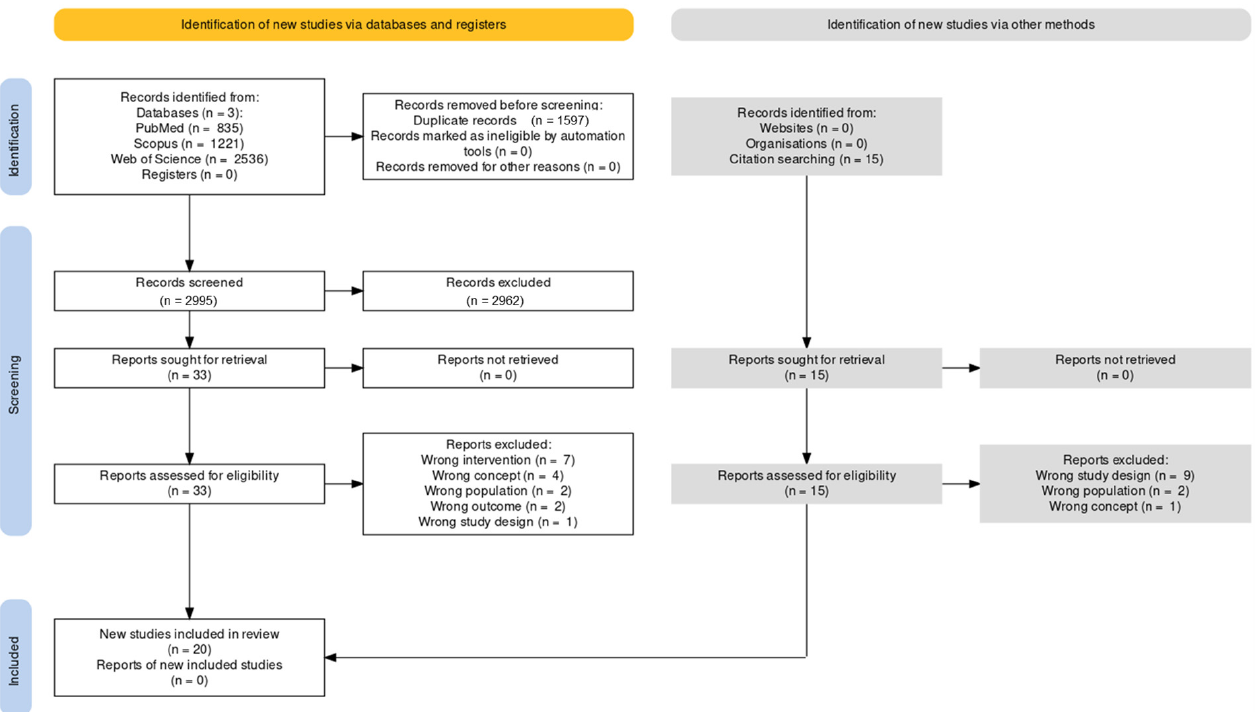
Figure 1. PRISMA-ScR flow diagram of the selection process. Of the 20 studies in the final review, 10 (50%) [49,50,53,54,56–58,60–62] were conducted in the USA, 6 (30%) in the UK [45,46,48,52,55,59], 2 (10%) in South Africa [44,51], and 2